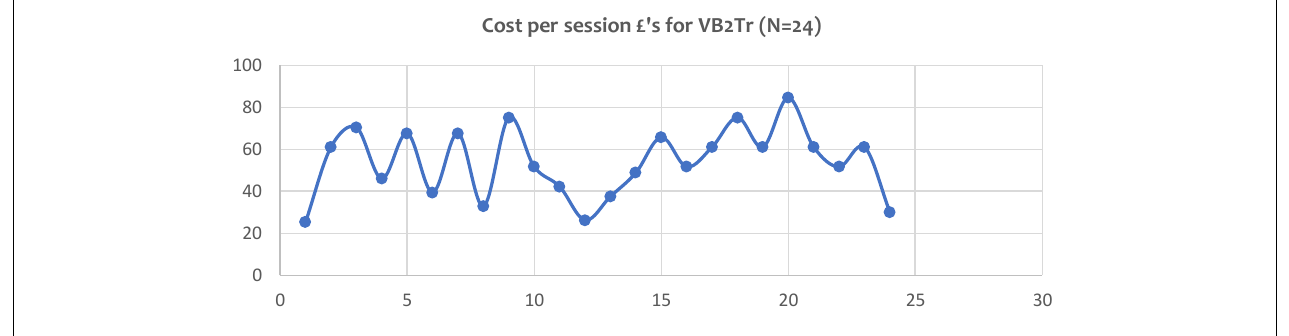
FIGURE 7 | Variance in cost of VB2Tr treatment sessions carried out as a